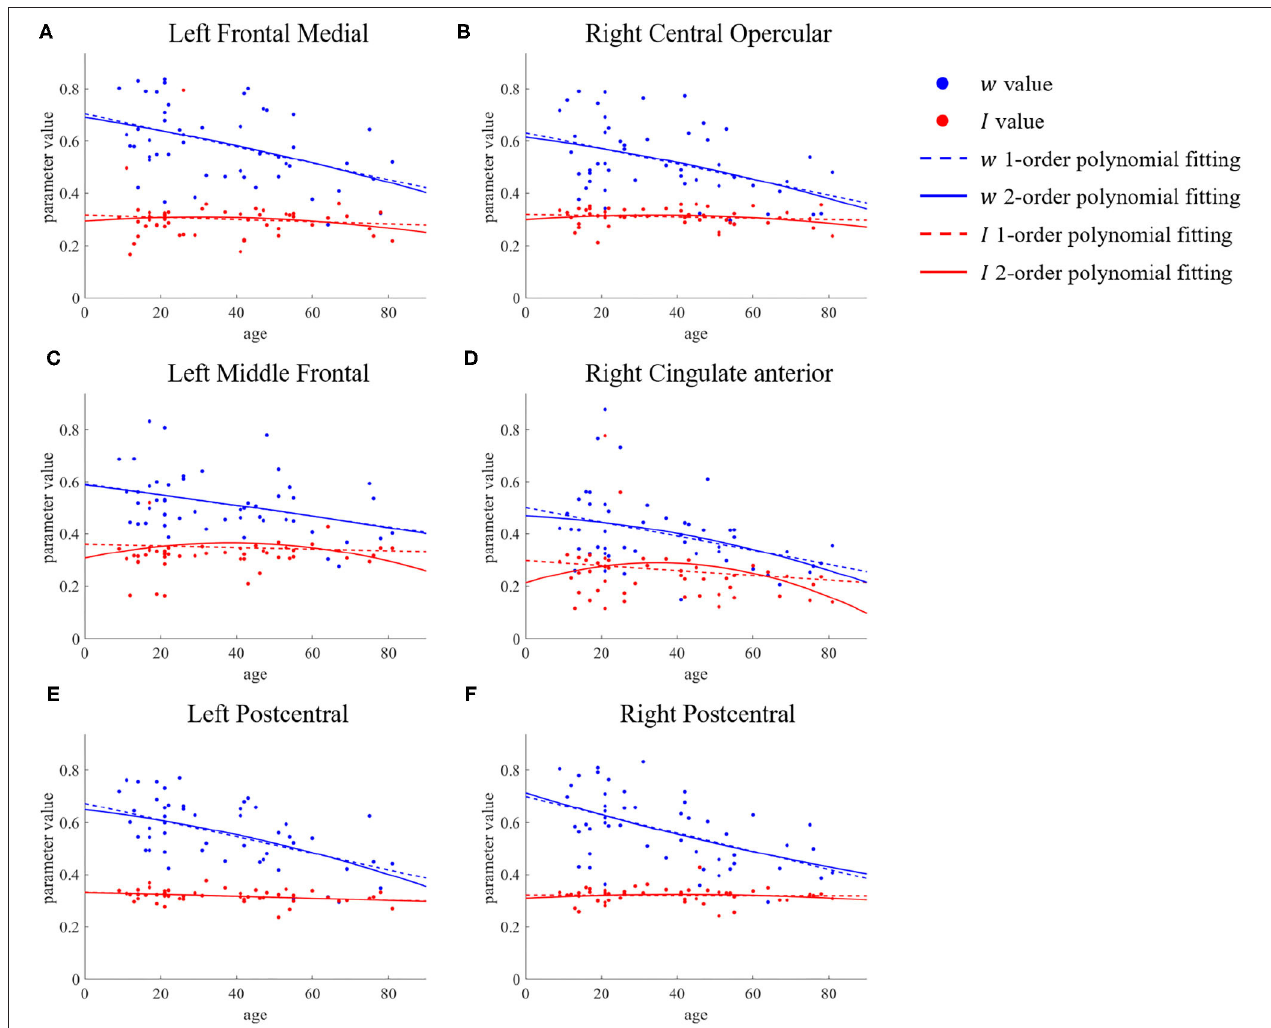
FIGURE 4 | ROIs with no significant difference in first- and second-order polynomial fits of recurrent connection strength w . The points represents the parameter values, the dashed lines are the first-order polynomial fits, and the solid lines are the second-order polynomial fits. Blue indicates w and red indicates I . (A) Left Frontal Medial. (B) Right Central Opercular. (C) Left Middle Frontal. (D) Right Cingulate anterior. (E,F) Bilateral